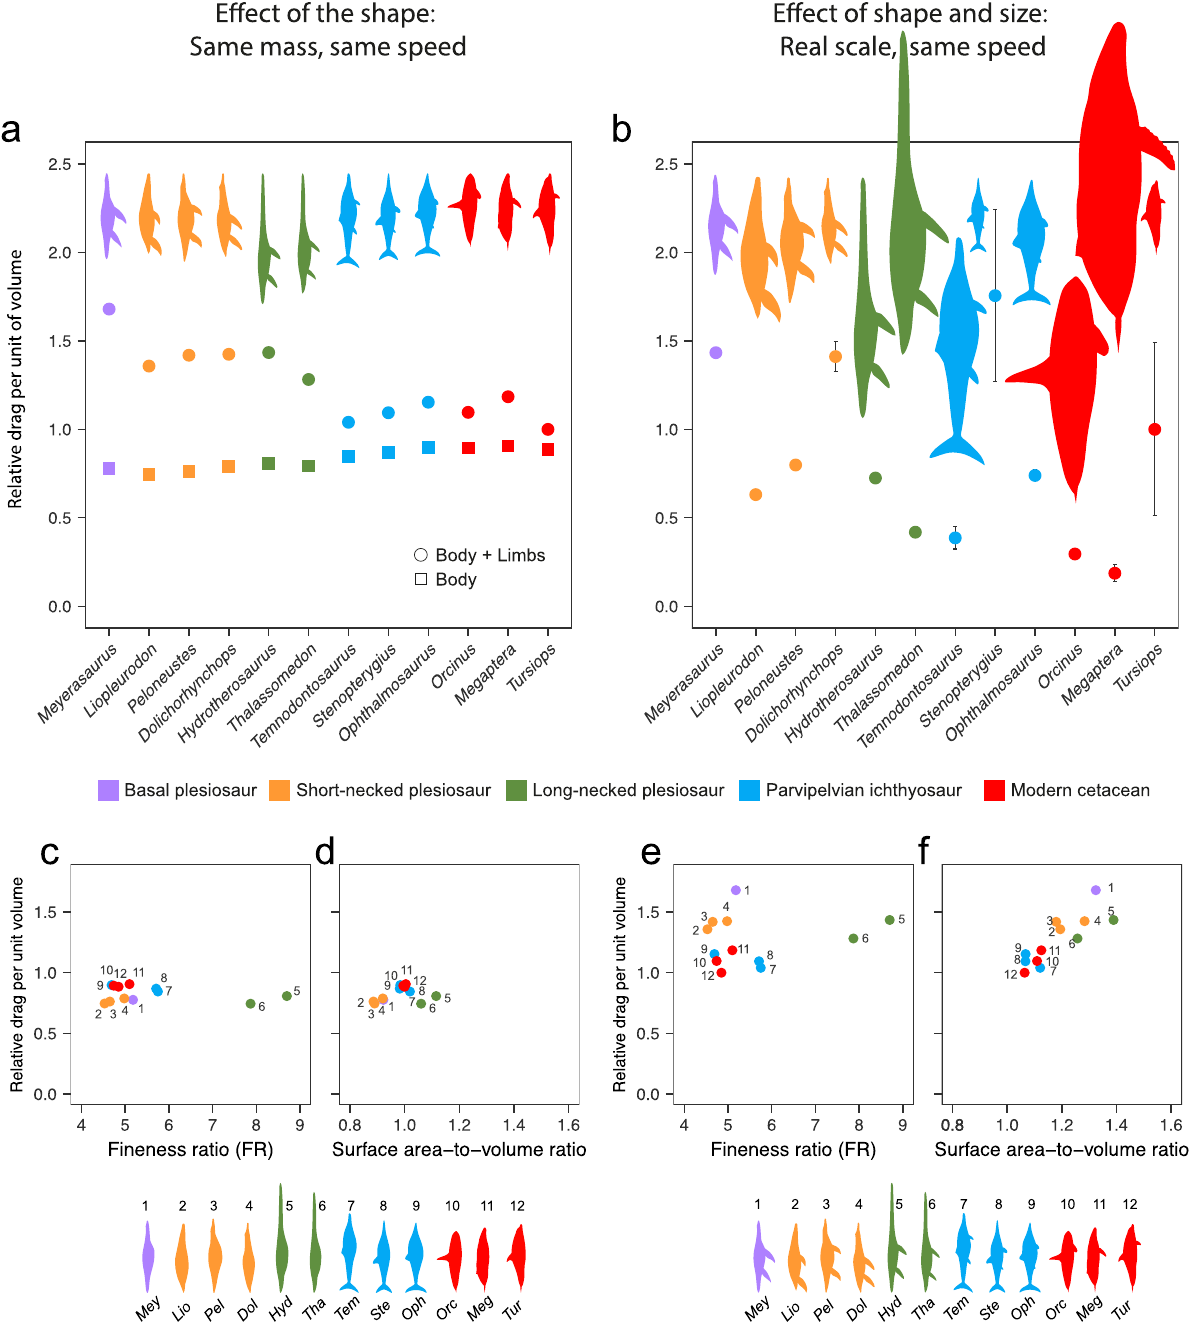
Fig. 2 Effects of body shape and body size on the drag-related costs of steady locomotion for derived sauropterygians, ichthyosaurs and cetaceans. a Relative drag per unit of volume (a proxy for the drag-related cost of steady locomotion or COT drag ) calculated for models scaled to the same total volume and compared at the same inlet velocity of 1 ms − 1 . Results are shown for the full models including the limbs (circles) and the limbless models (squares). Average of calculations performed with two different volumes (see Supplementary Data). b Relative drag per unit of volume for life-size scaled models compared at the same inlet velocity of 1 ms − 1 . Error bars represent minimum and maximum values accounting for taxon body size variation (see Supplementary Data). For an alternative set of calculations at 2 ms − 1 , see Supplementary Fig. 3. c – f Relative values of drag per unit of volume for models scaled to the same volume and measured at the same inlet velocity of 1 ms − 1 , corresponding to results in a , plotted against the fi neness ratio, FR ( c , e ) and the surface area-to-volume ratio ( d , f ). Results are shown for limbless ( c , d ) and full ( e , f ) models. All values are normalised to the results for the Tursiops model. Derived short-necked plesiosaurs are highlighted in orange; the parvipelvian ichthyosaurs in blue and the extant cetaceans in red. A basal plesiosaur included as a reference is highlighted in